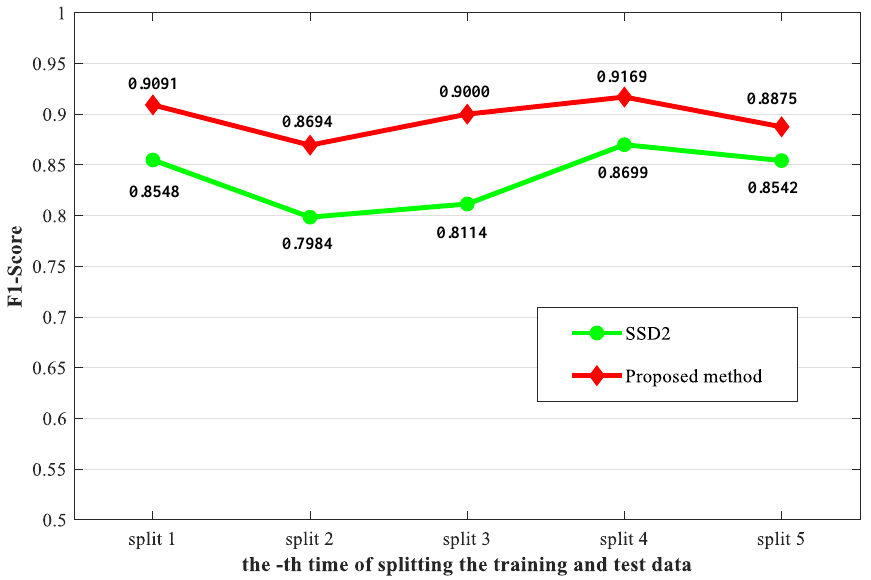
Figure 9. The detection performance of the proposed method and SSD2 for each split.